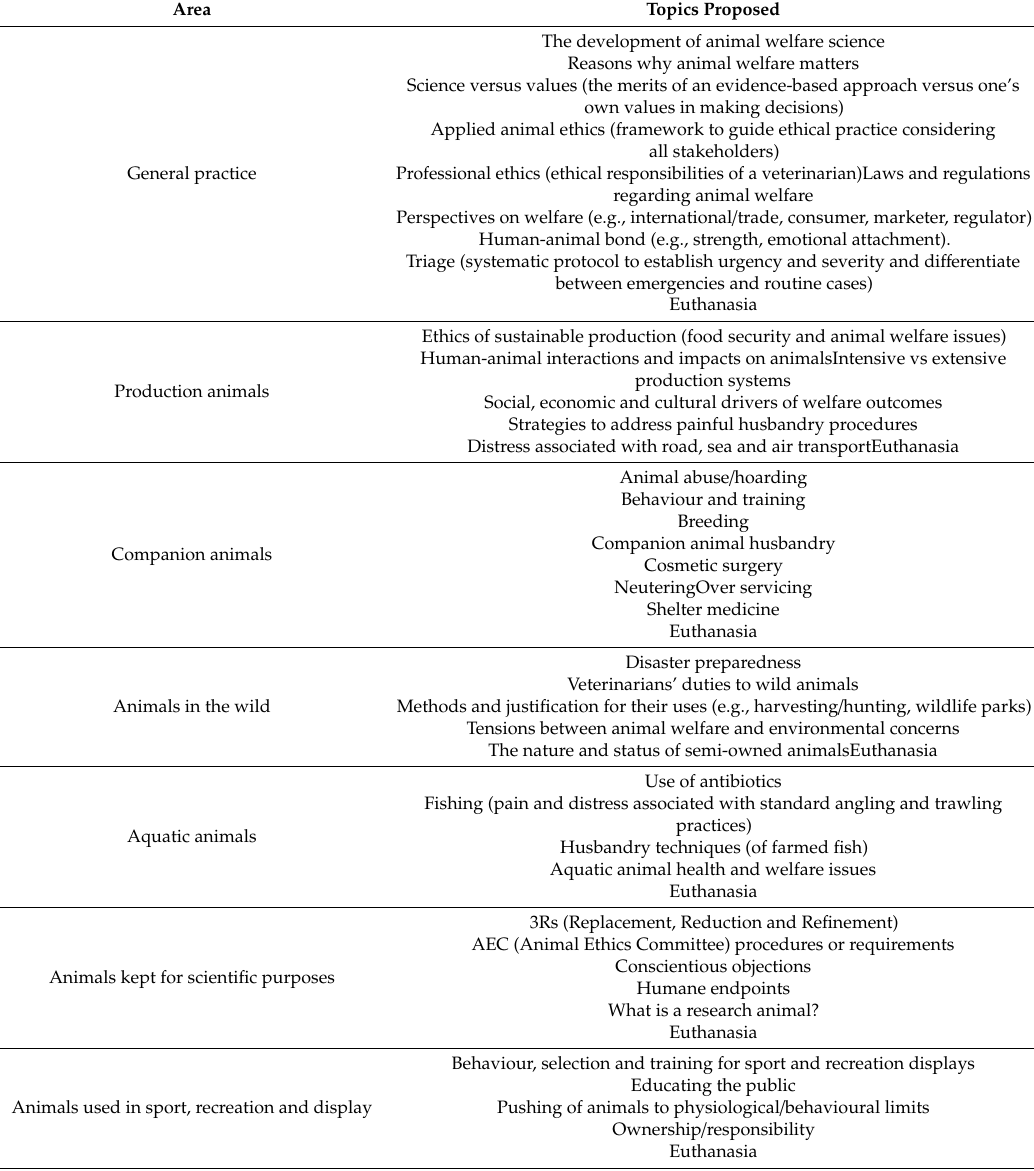
Table 2. Topics considered according to seven areas of veterinary